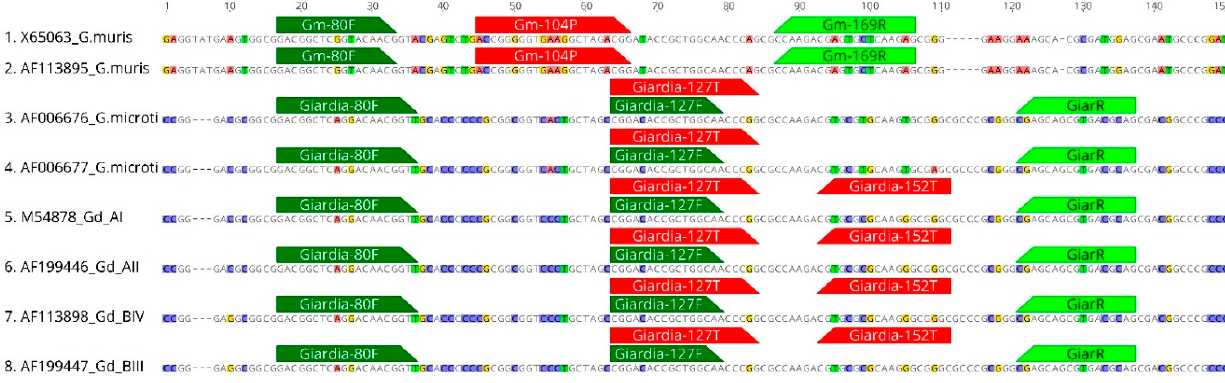
Figure 1. Alignment of the partial SSU gene locus of selected Giardia reference sequences illustrating the position of the primers and probes of the newly developed real-time PCR approaches. Forward primers in dark green, reverse primers in light green and probes in red.